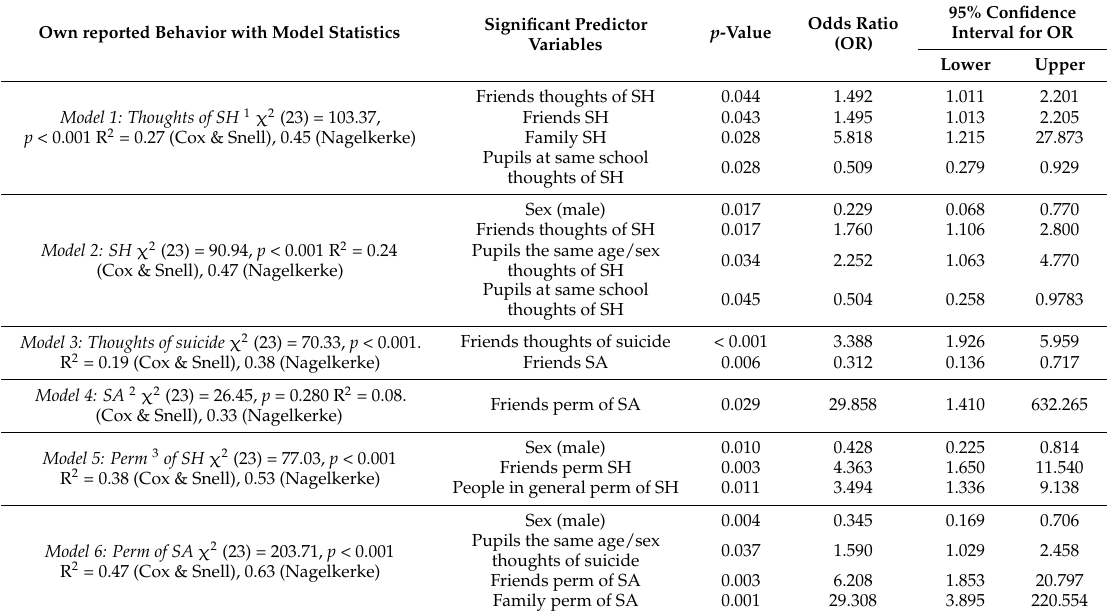
Table 3. Binary logistic regression analyses of variables significantly associated with reported norms.